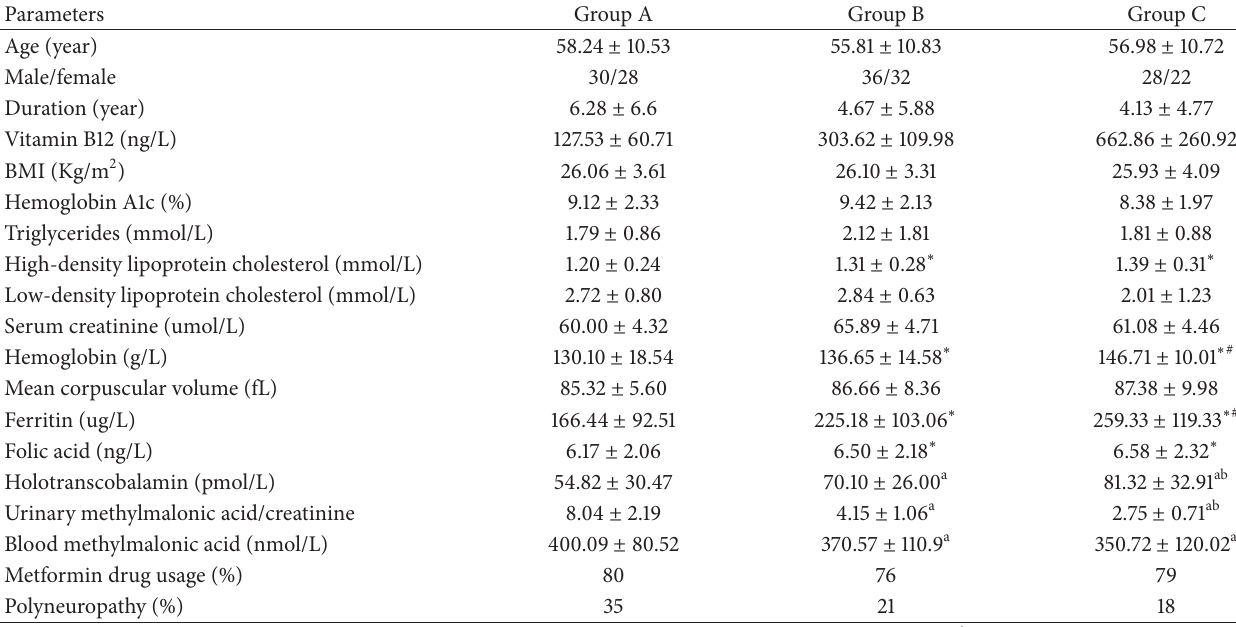
Table 1: Comparison of the clinical data among the three groups.